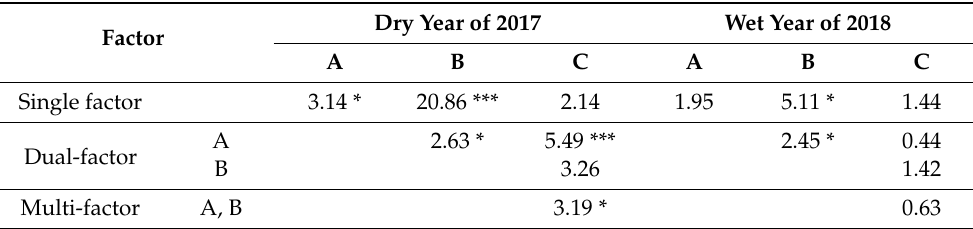
Table 1. Multi-factor effects on the change of root zone soil salinity in the crop growing season by variance